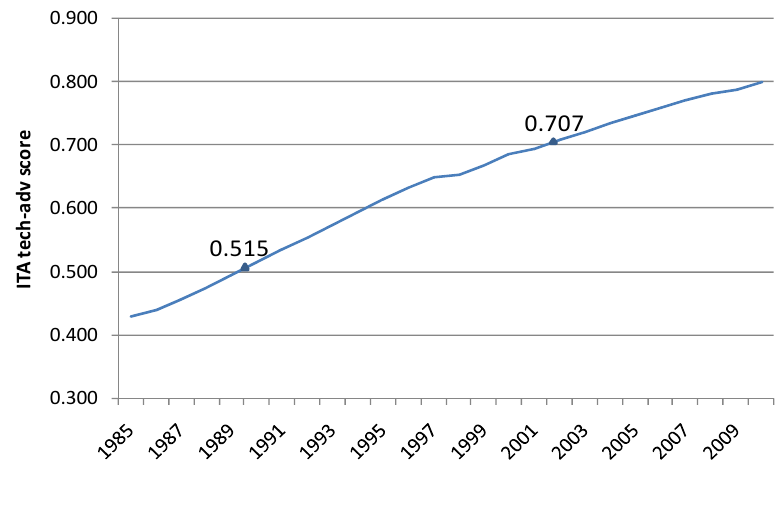
score (data source: [50]). Tech-Adv